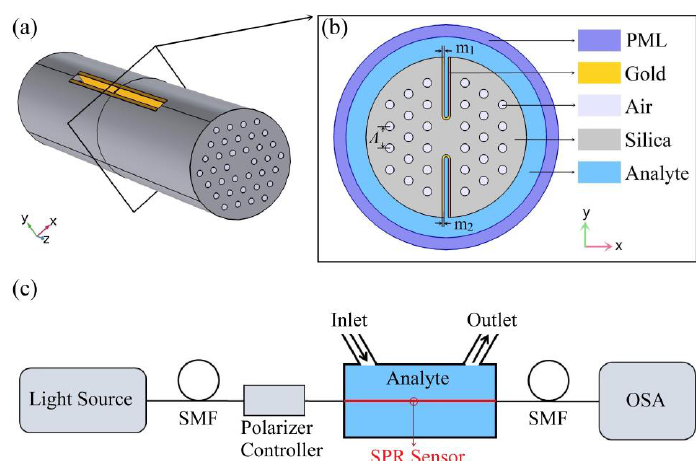
Figure 1. ( a ) Schematic diagram of the proposed H-shaped photonic crystal fiber-based surface plasmon resonance (PCF-SPR) sensor; ( b ) cross-section of the SPR sensor; ( c ) experimental setup of the SPR sensor for refractive index (RI) detection.